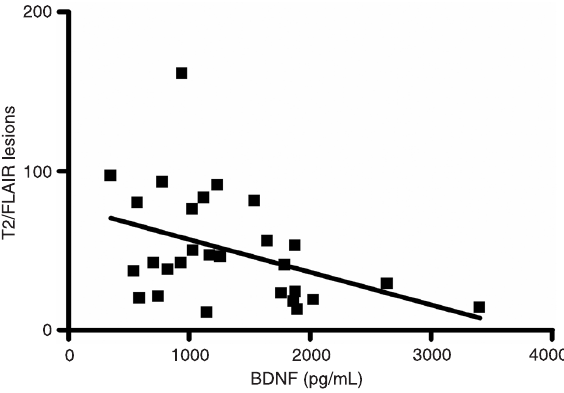
Figure 1. BDNF levels are inversely correlated with the number of T2/FLAIR lesions determined by MRI. Serum from MS pa- tients (N = 28) was collected and BDNF levels were measured by ELISA. There was a significant negative correlation (P = 0.0292) between BDNF levels and T2/FLAIR lesions. BDNF = brain-de- rived neurotrophic factor; T2/FLAIR = T2/fluid-attenuated inver- sion recovery.